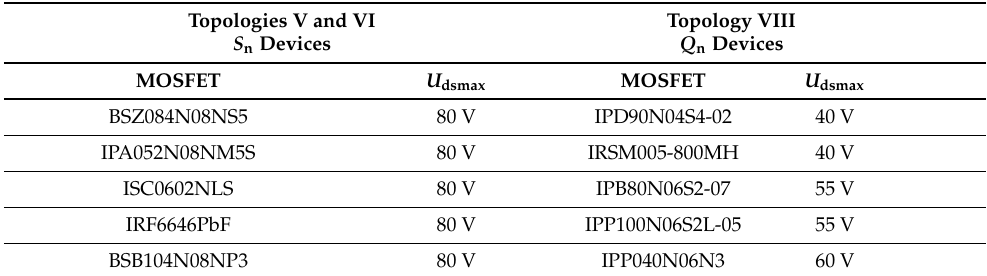
Table 18. MOSFET used for the Pareto front estimation of the BIC and SCIC for topologies V, VI, and VIII, as depicted in Figure